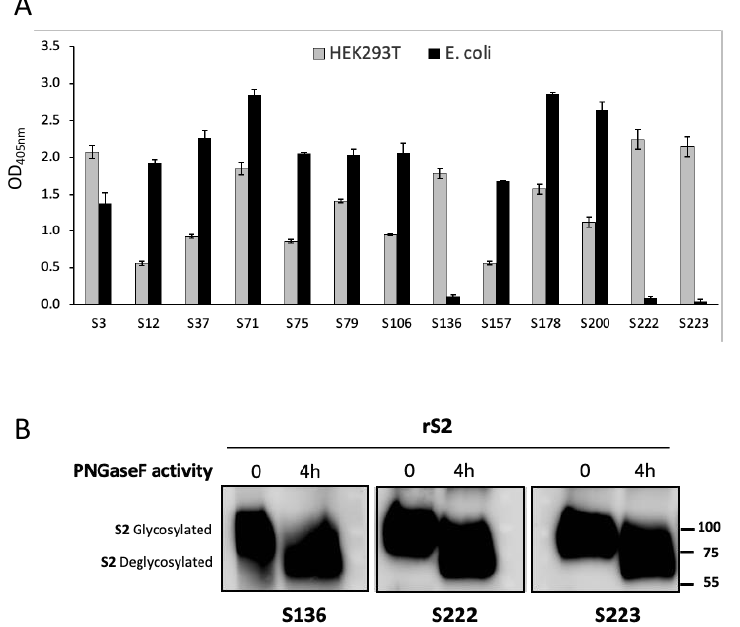
Figure 3. mAbs specific biding to rS1 or rS2 produced in HEK293T or in E. coli . ( A ) The binding of selected mAbs to the specific recombinant domain produced in mammalian (HEK293T) or prokaryotic ( E. coli ) expression systems evaluated by ELISA. Error bars indicate the standard deviations of technical duplicates from a representative experiment repeated three times. ( B ) WB analysis of anti-S2 mAbs S136, S222, and S223. In SDS-PAGE rS2 before and after glycosidase PNGase F treatment for 4 h. The positions of glycosylated and deglycosylated protein are indicated. A representative experiment of two is shown.